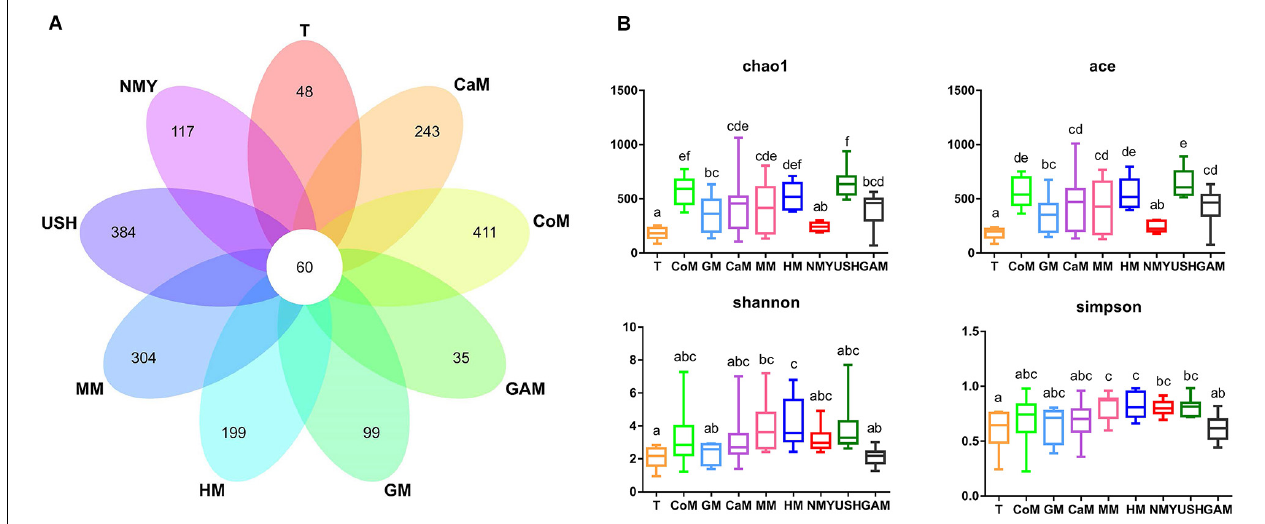
FIGURE 3 | (A) Venn diagram of OTUs; (B) Four metrics of analysis for alpha-diversity among all groups. T, initial infant fecal slurry of ten infants; NMY and USH, infant formula powder; CoM, cow milk; GM, goat milk; CaM, camel milk; MM, mare milk; HM, human milk; GAM, Gifu anaerobic medium.